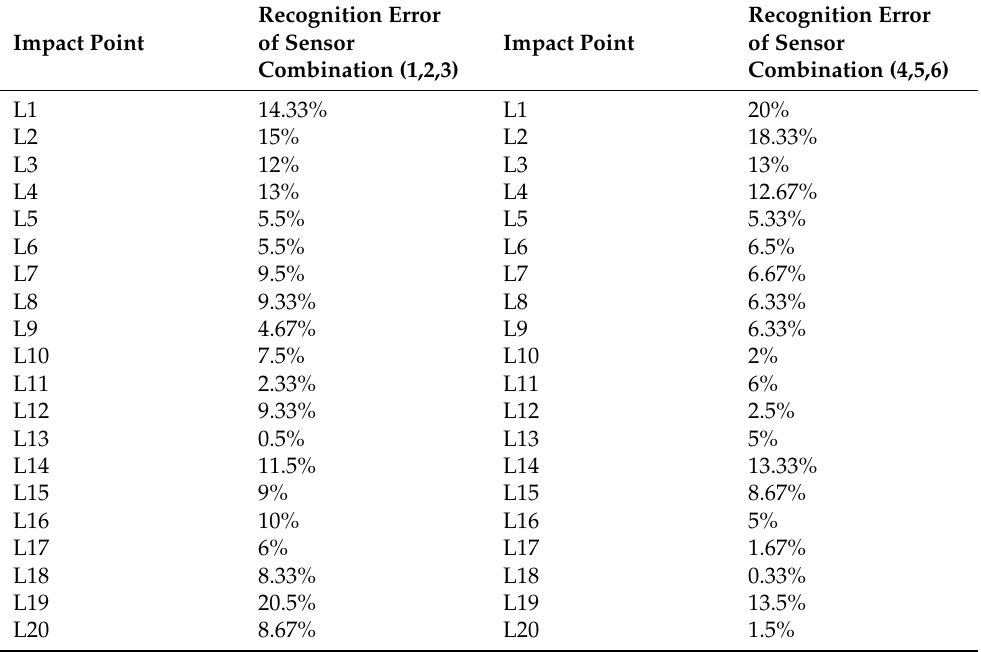
Table 8. Recognition results comparison of sensor